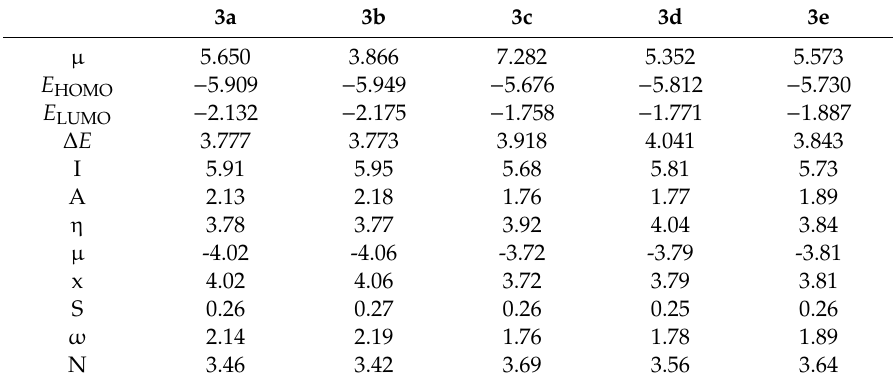
Table 3. The calculated dipole moment ( µ ), E HOMO , and E LUMO and the calculated reactivity indices (eV) of the studied compounds calculated using B3LYP / 6-311G(d,p) method. 3a 3b 3c 3d